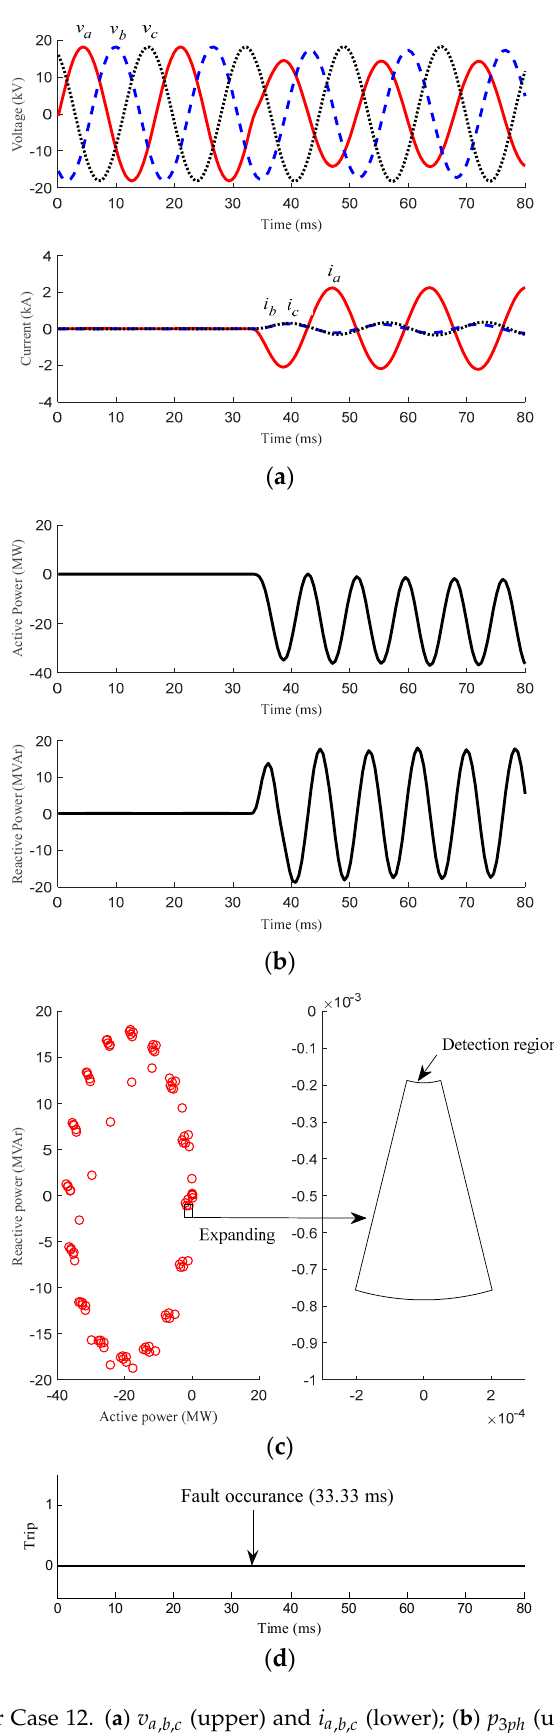
Figure 14. Results for Case 12. ( a ) v a , b , c (upper) and i a , b , c (lower); ( b ) p 3 ph (upper) and q 3 ph (lower); ( c ) Trajectories of the point ( p 3 ph , q 3 ph ); ( d ) Islanding detection signal.